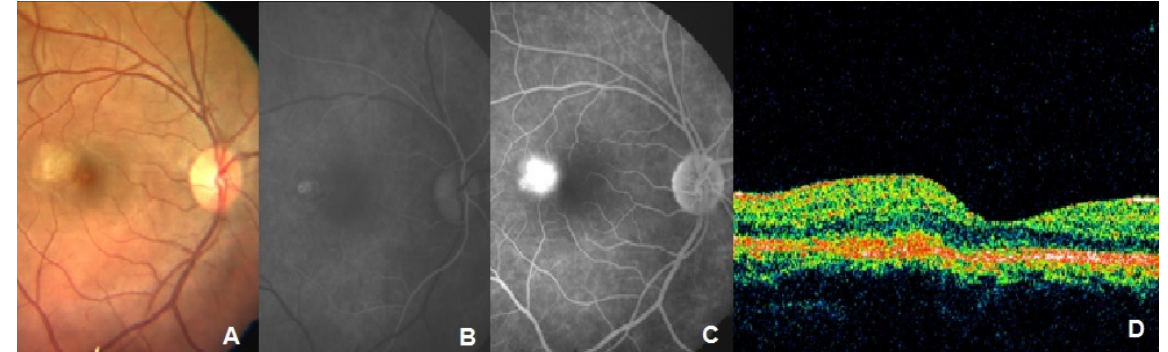
Figure 1: Color photo, early and late images of FFA and OCT picture at baseline